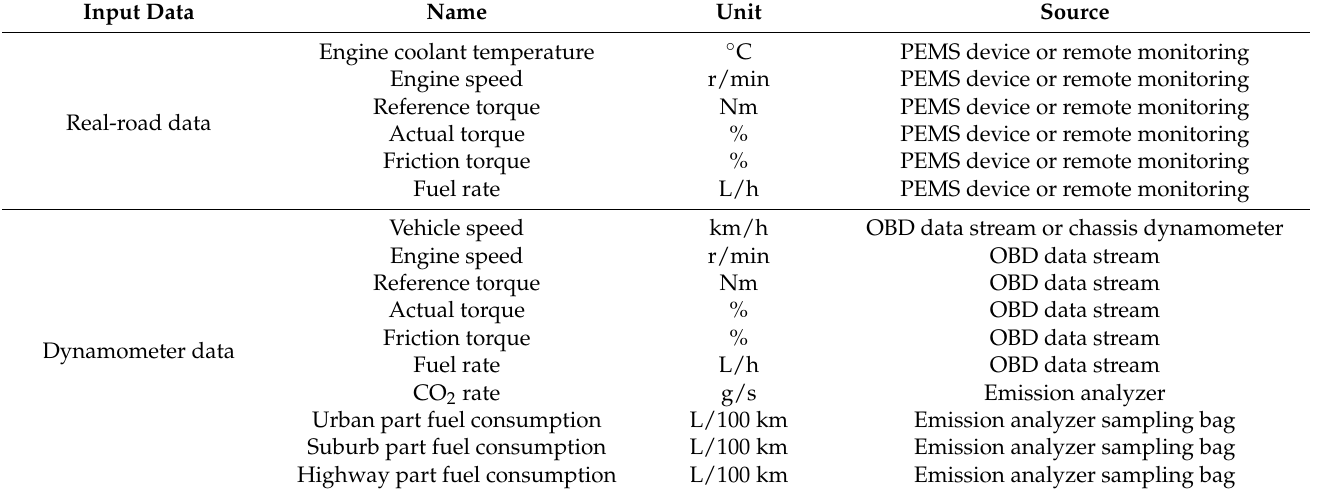
Table 2. Input Table 2. Input data.